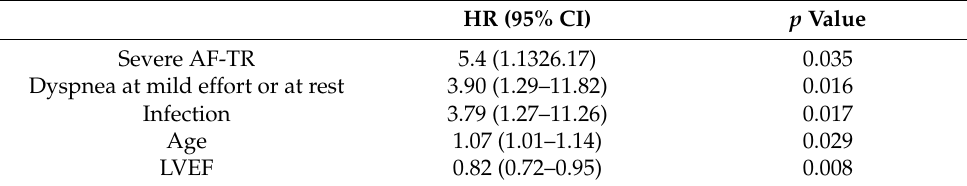
Table 6. Cox proportional hazards analysis—predictors of mortality in AF